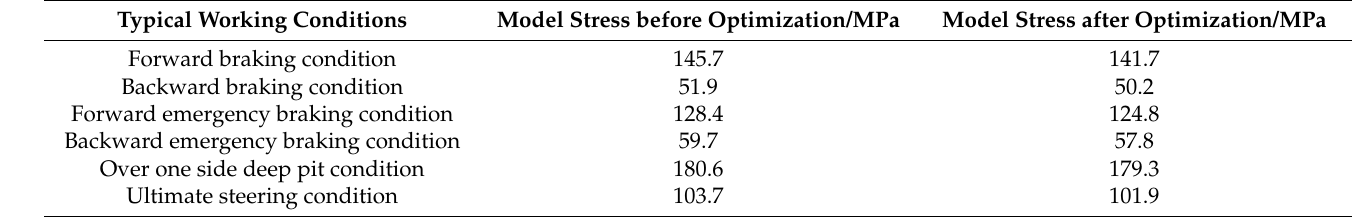
Table 6. Comparative analysis results of stress before and after optimization of aluminium alloy front